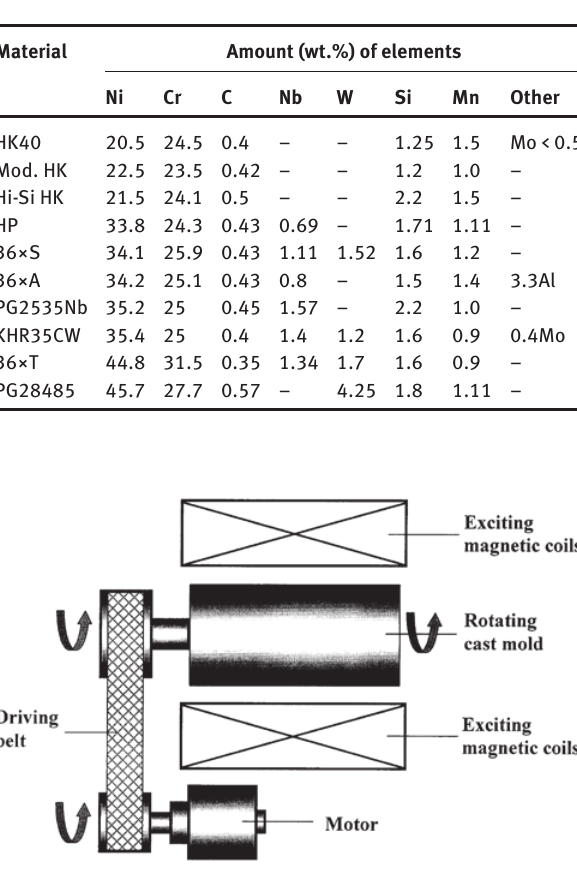
Table 1: Chemical compositions of typical tube materials [12].